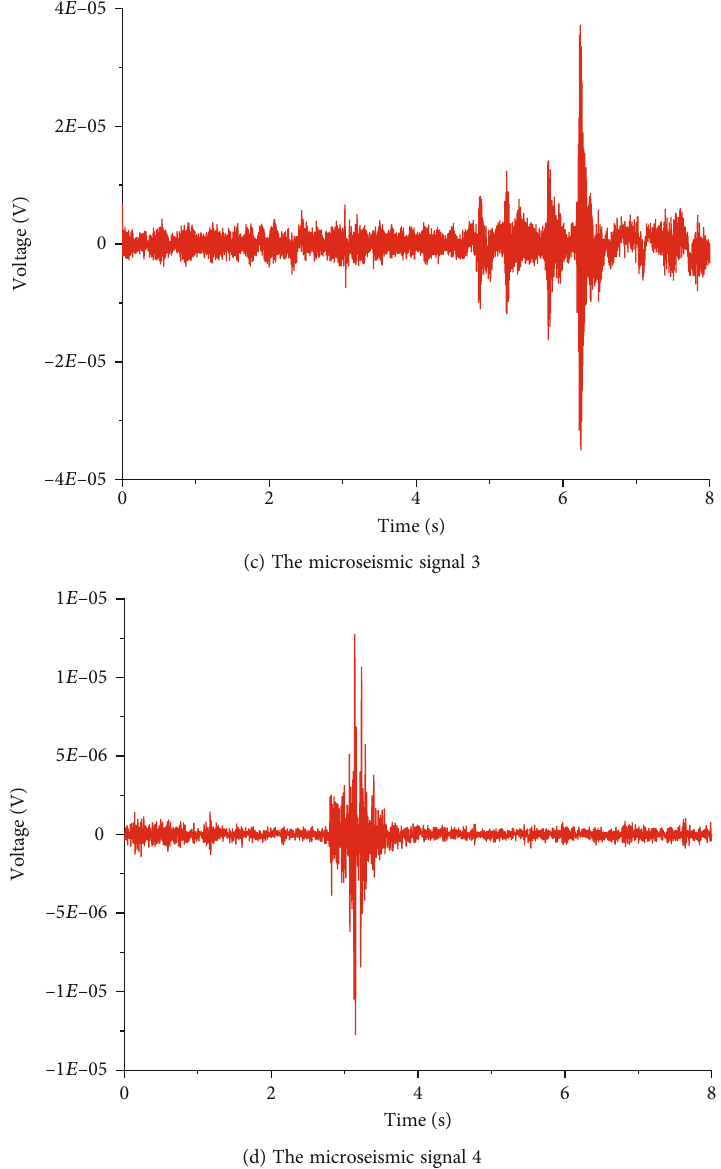
Figure 18: Waveform of microseismic signals detected by the designed